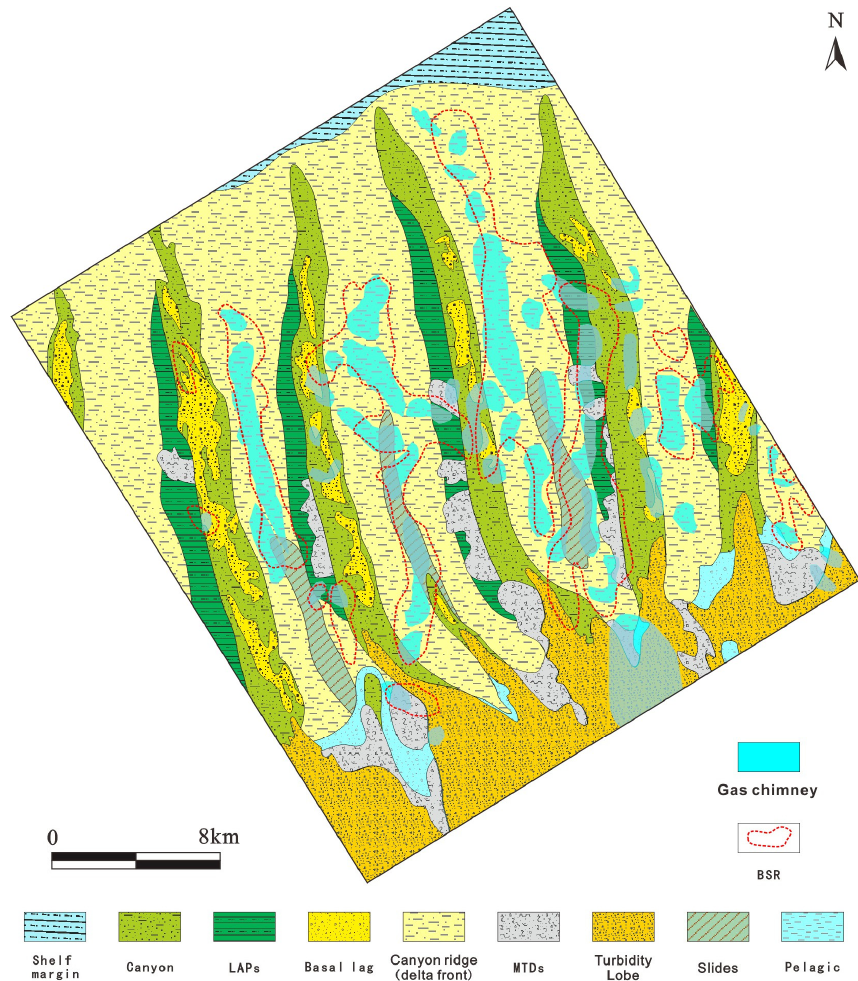
Figure 11. Spatial location relationship of BSRs, gas chimneys and sedimentary facies.